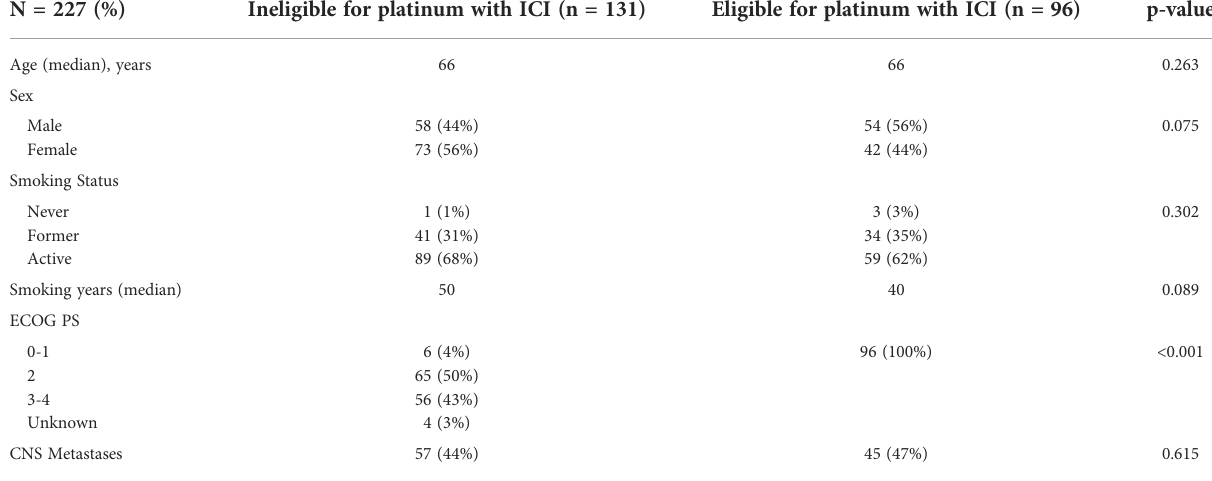
TABLE 2 Extensive stage small cell lung cancer patients who received fi rst line platinum doublet by eligibility for fi rst line chemotherapy with immune checkpoint inhibitor.